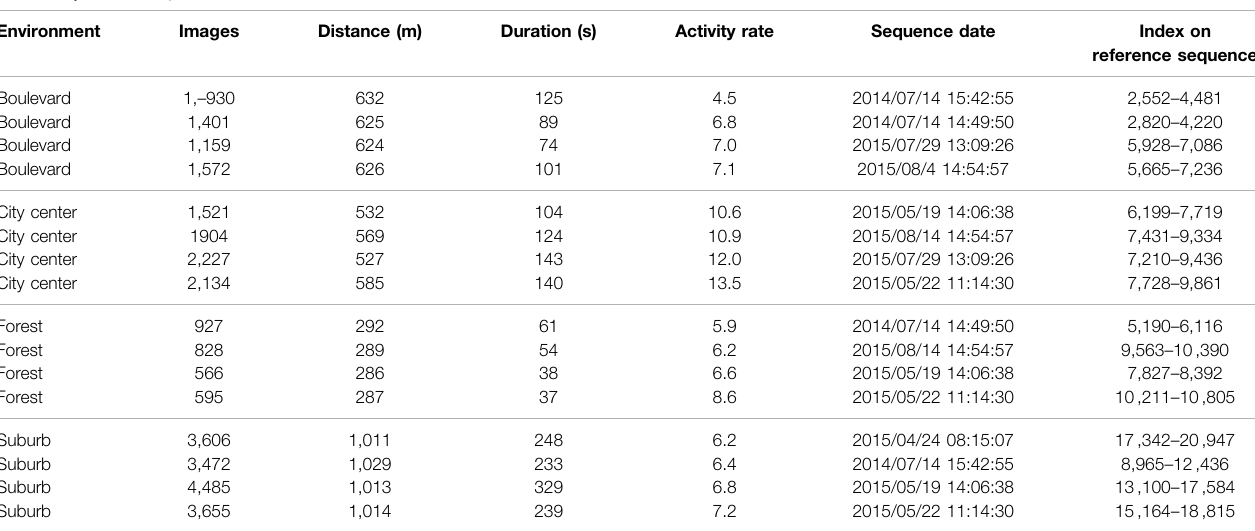
TABLE 1 | Different trajectories selected from the Oxford car dataset Environment